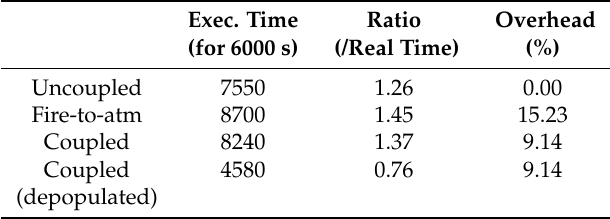
Table 2. Computation time for the different